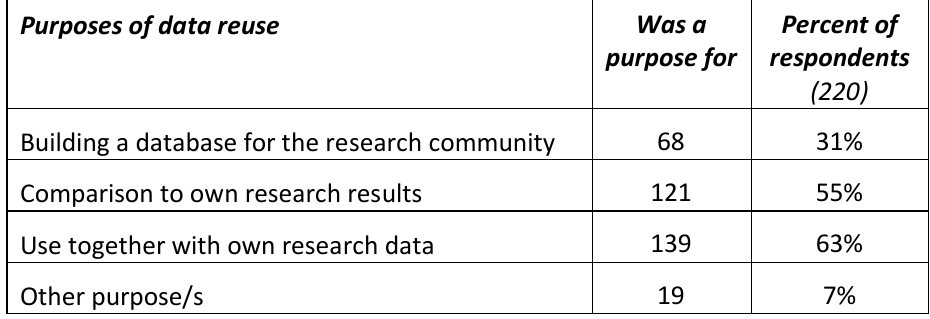
Table 12 : Purposes of data reuse (multiple answers